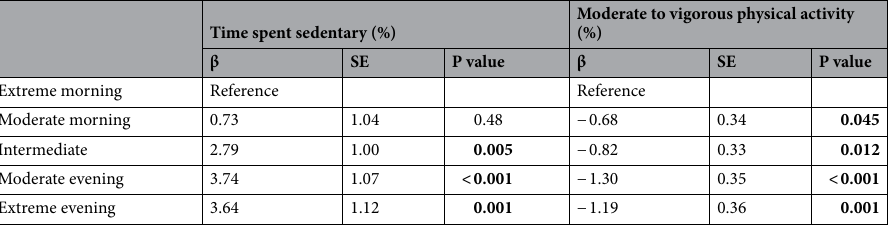
Table 2. Association between chronotypes and physical activity pattern in generalized linear regression models. Controlled for gender, age, body mass index, waist circumference, SES, smoking, unhealthy drinking, university education, work status, depression symptoms, hypertension and self-reported diabetes mellitus.